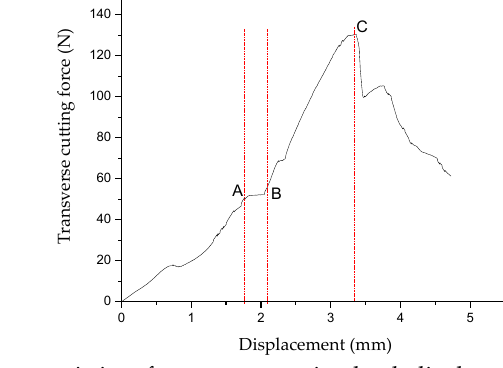
Figure 9. Results of transverse cutting test: A is approximately regarded as the dividing point between elastic stage and yield stage; B is approximately regarded as the dividing point between yield stage and strengthening stage; C is approximately regarded as the point of tensile strength.